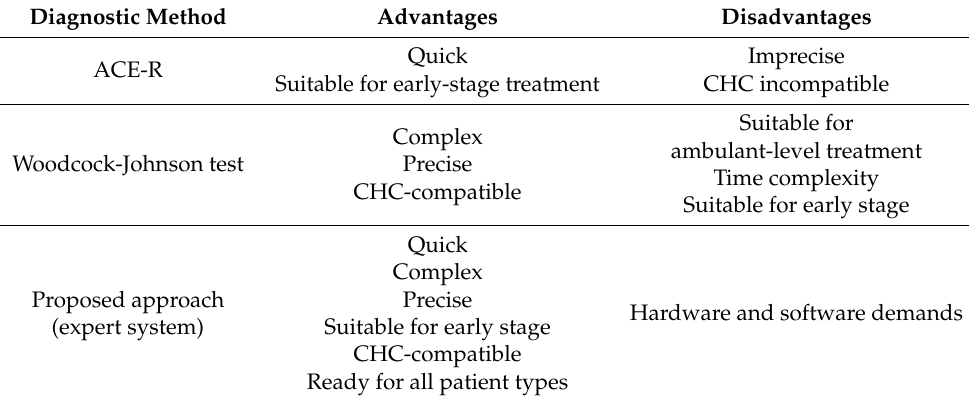
Table 1. Comparison of ACE-R and CHC with the proposed